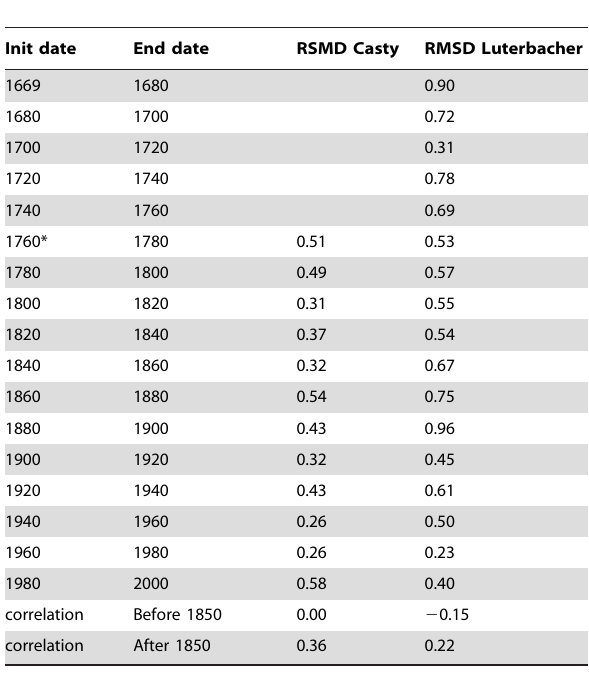
Table 1. Comparison of the reconstructions with previous works.